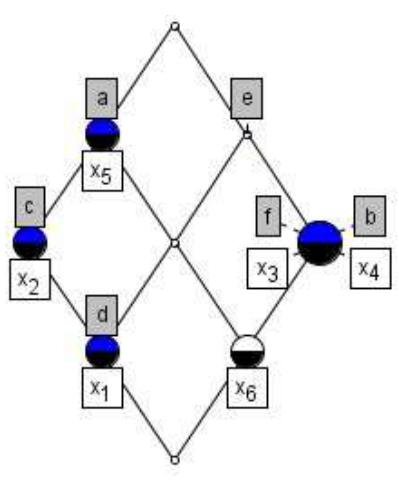
Figure 9. The concept lattice of Table 4.